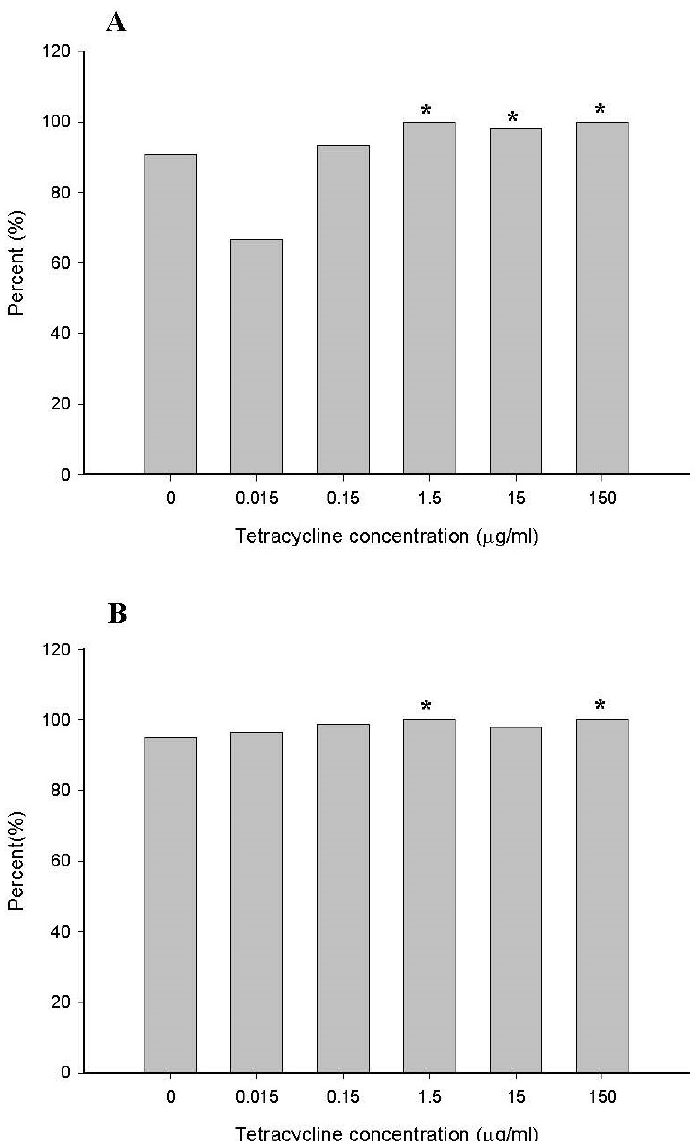
Figure 7. Comparison of percentage of tetracycline resistance (MIC > 16 µ g/mL) of family Enter- obacteriaceae ( A ) and genus Escherichia ( B ) in controls (no treatment) and tetracycline-treated samples after 7 days. * indicates statistically significant differences from control ( p <